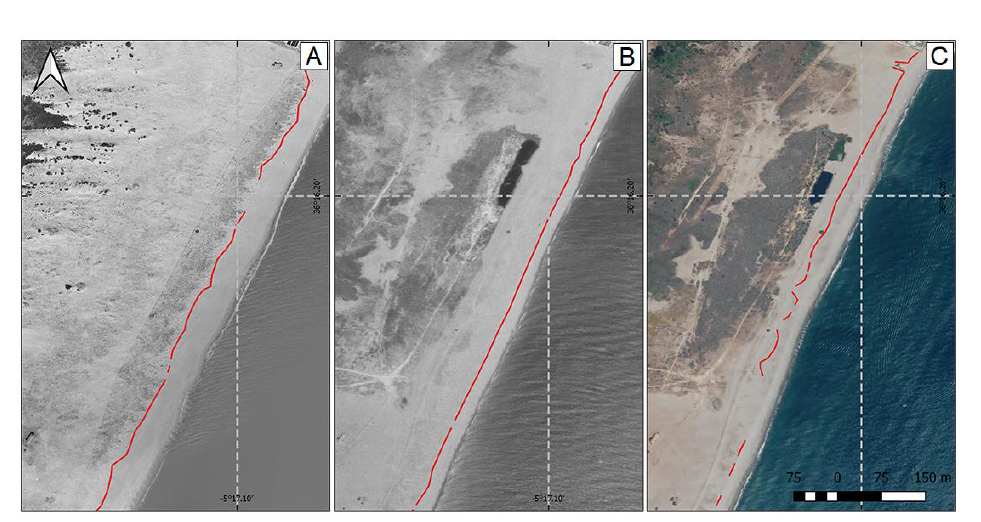
Figure 12. Details of the central area of System no. 9 Guadalquitón (Cádiz province), where washover fans and pathways were observed. Red line represents dune toe position. ( A ) 1977, ( B ) 2001 and ( C ) 2016.